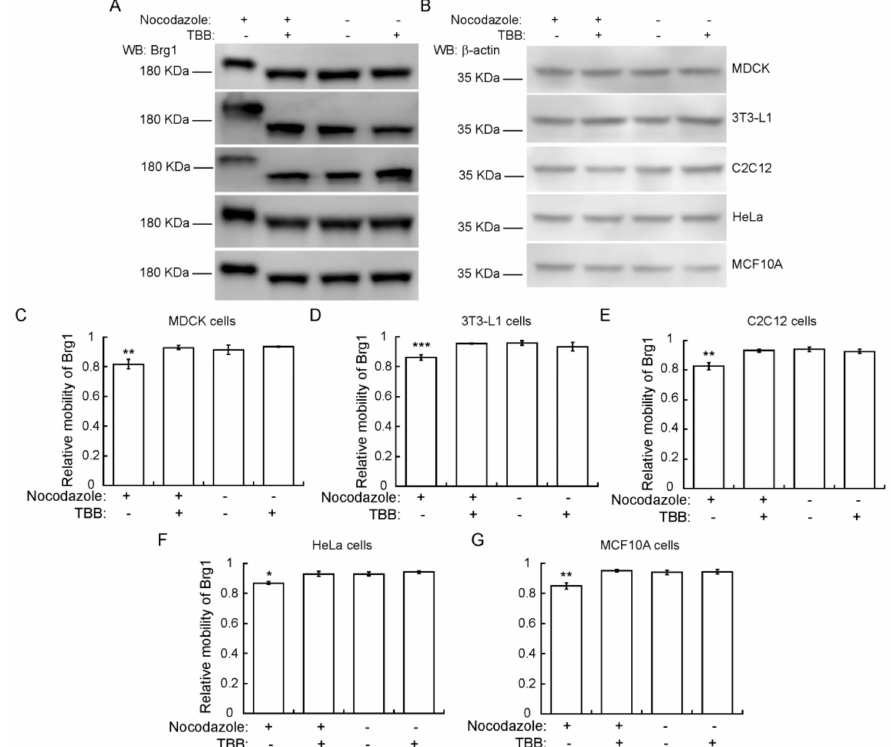
Figure 5. CK2-dependent phosphorylation of Brg1 in mitosis is a conserved event in di ff erent cell types and species. ( A ) Madin-Darby canine kidney (MDCK), 3T3-L1, C2C12, HeLa, and MCF10A cells